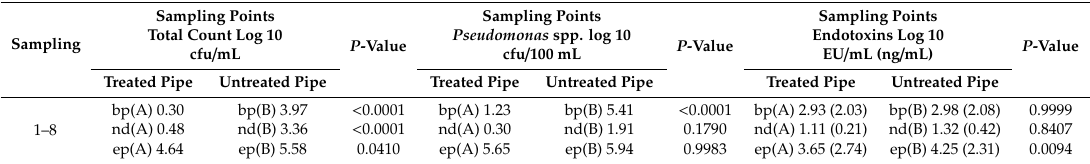
Table 2. Results from compartment A (treated pipe) and compartment B (control pipe).